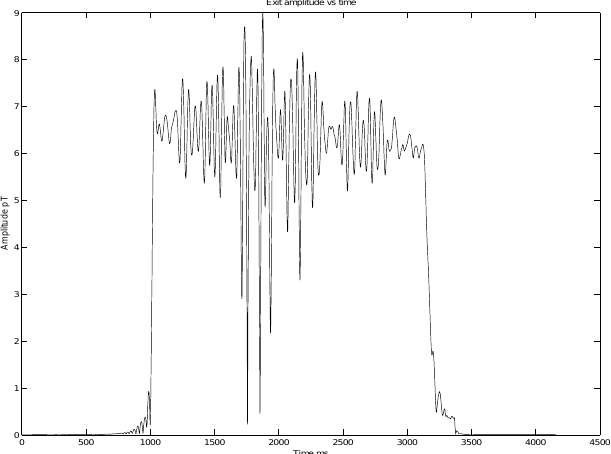
Fig. 7. Snapshot of the faller generation region of the downward falling hook shown in fig 6, at t=1975ms. Note that the wave profile extends well upstream of the equator (i.e. on the transmitter side) and that consequently particle trapping occurs in this region; this results in a positive value for J i , the resonant particle current in the wave magnetic field direction. The lower curve attaining a value –12 is J i